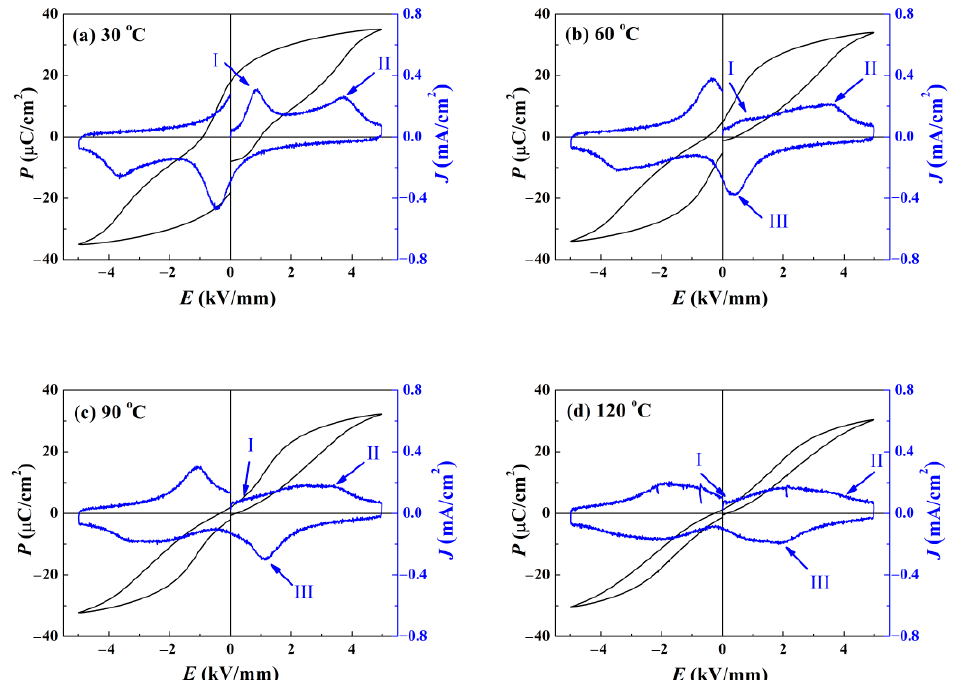
Figure 7. Temperature dependent polarization-electric field P – E hysteresis curve for the pure BNKT– BT: ( a ) 30 ◦ C, ( b ) 60 ◦ C, ( c ) 90 ◦ C, and ( d ) 120 ◦ C. As temperature increases, Peak I shifts towards